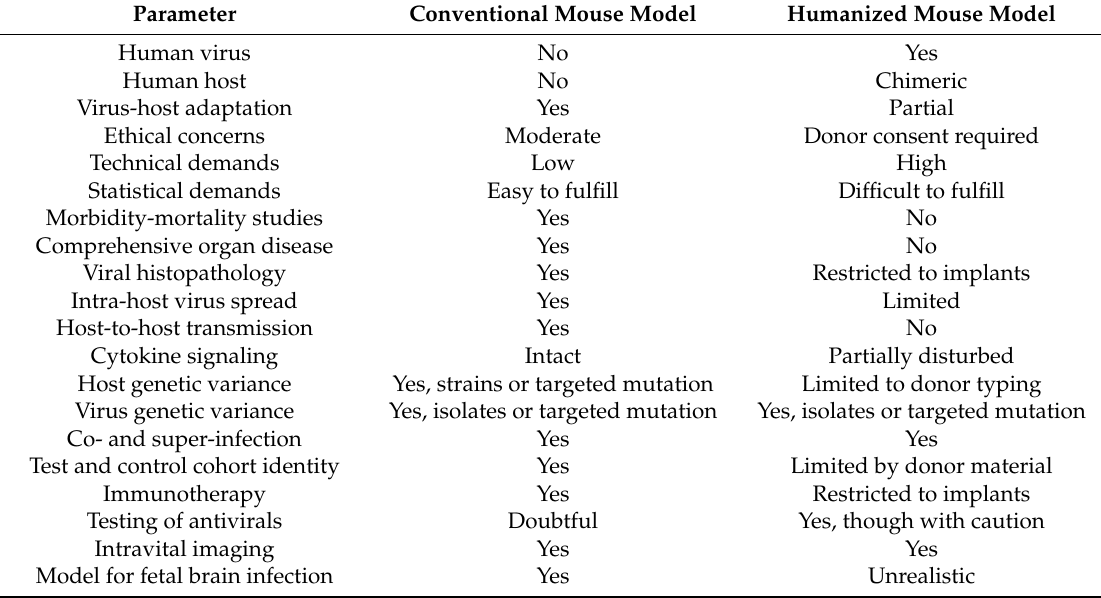
Table 1. Strengths and weaknesses of conventional and humanized mouse